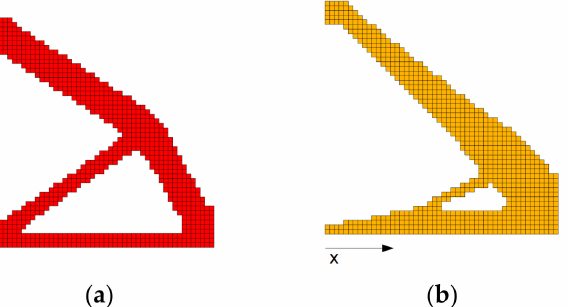
Figure 3. Final topologies obtained for square structure for FGM-SIMP material interpolation scheme, x -direction of material gradation: ( a ) uniform material, minimal compliance: 2.588 Nm; ( b ) graded material according to Equation (7), minimal compliance: 15.427